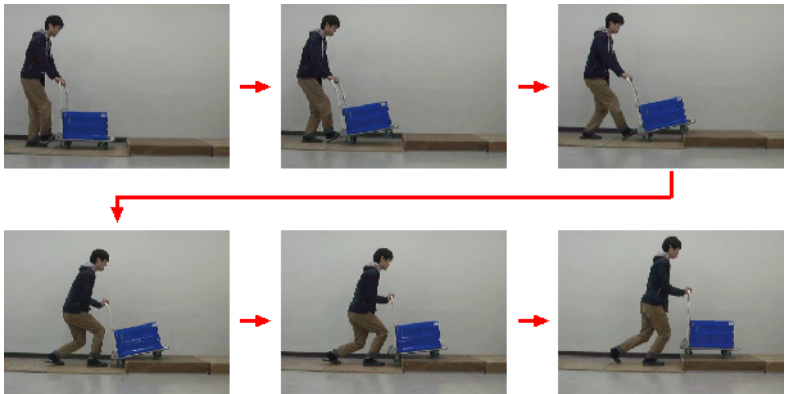
Figure 4. Human method of pushing a hand cart up a step